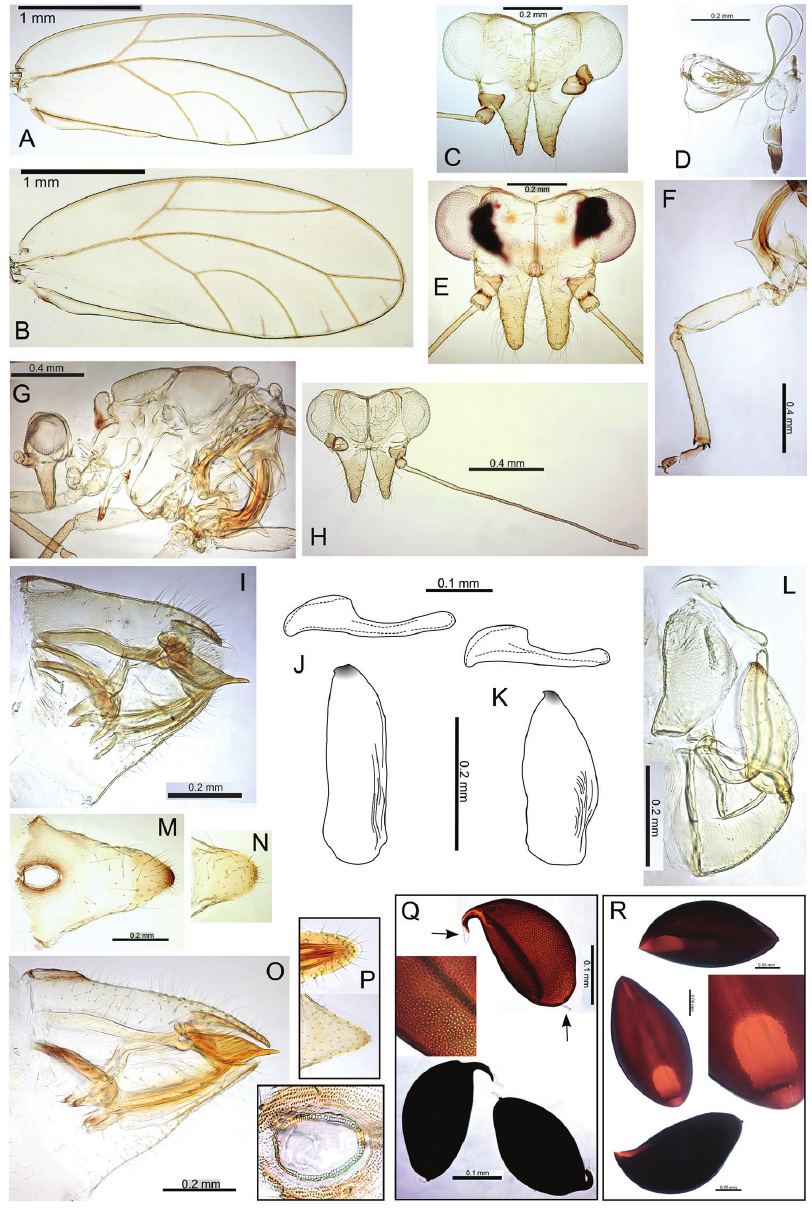
Figure 38. Pariaconus mauiensis sp. n. A, B fore wing: A form mauiensis B form kuula C, D form mauiensis : C head D proboscis E head (uncleared ocular tissue), form kuula F hind leg G head and thorax H head and antenna (female) I female terminalia, form mauiensis J aedeagus and paramere, form kuula K, L, M, N form mauiensis : K aedeagus and paramere L male terminalia M female proctiger (dorsal view) N female subgenital plate apex (ventral view) O, P form kuula : O female terminalia with detail of anal ring (inset) P apices of female proctiger (above) and subgenital plate (below) Q, R eggs (pedicel and tail indicated, microsculpturing detailed): Q form mauiensis R form kuula